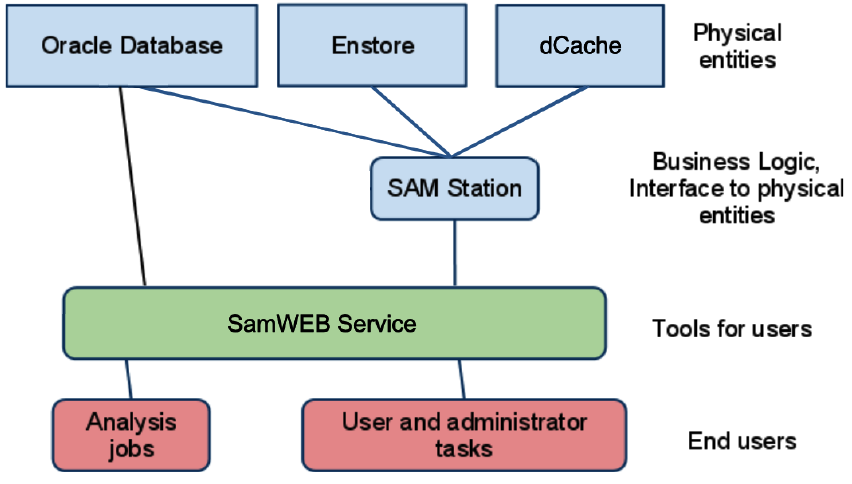
Figure 1. Schematic overview of the CDF data handling system at FNAL. The various components are described in the following